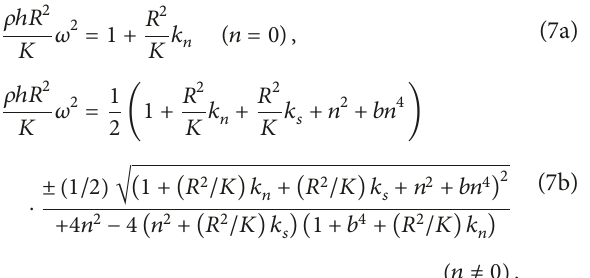
dimensions. The thin shell theory can be used for the analysis of tunnel lining vibration. The vibration properties of thin elastic shell have been studied by many researchers [23, 24].